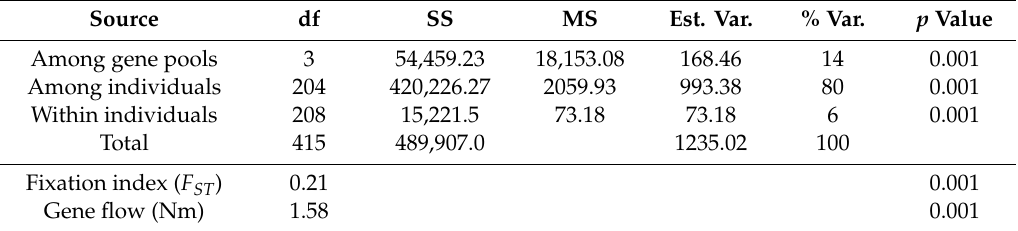
Table 2. Analysis of molecular variance (AMOVA) using 5974 DArTseq markers of the genetic variation among and within four gene pools of 208 maize accessions.